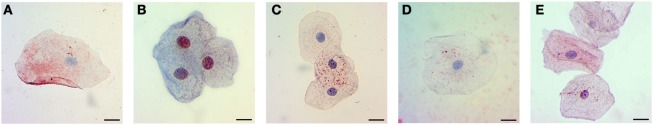
Immunocytochemistry for Tau and p-Tau in oral mucosa cells. Assay of different monoclonal antibodies. (A) Tau-5. (B) p-Tau (Ser396). (C) p-Tau (Thr231). (D) p-Tau (Ser214). (E) p-Tau (Ser202 + Thr205). The scale bars represent 20 µm for all images.